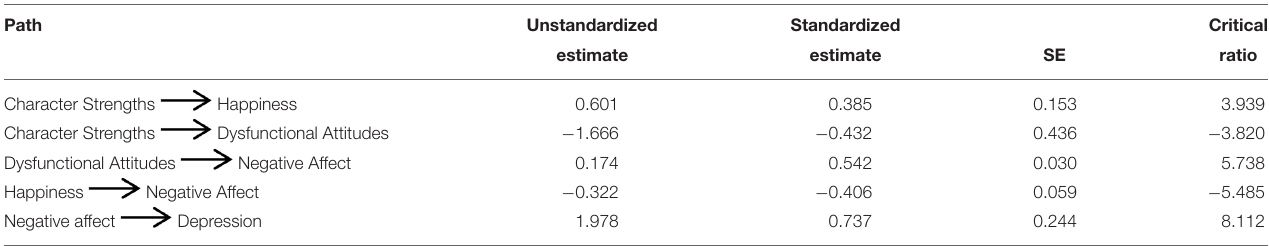
TABLE 3 | Maximum likelihood estimates for the modified